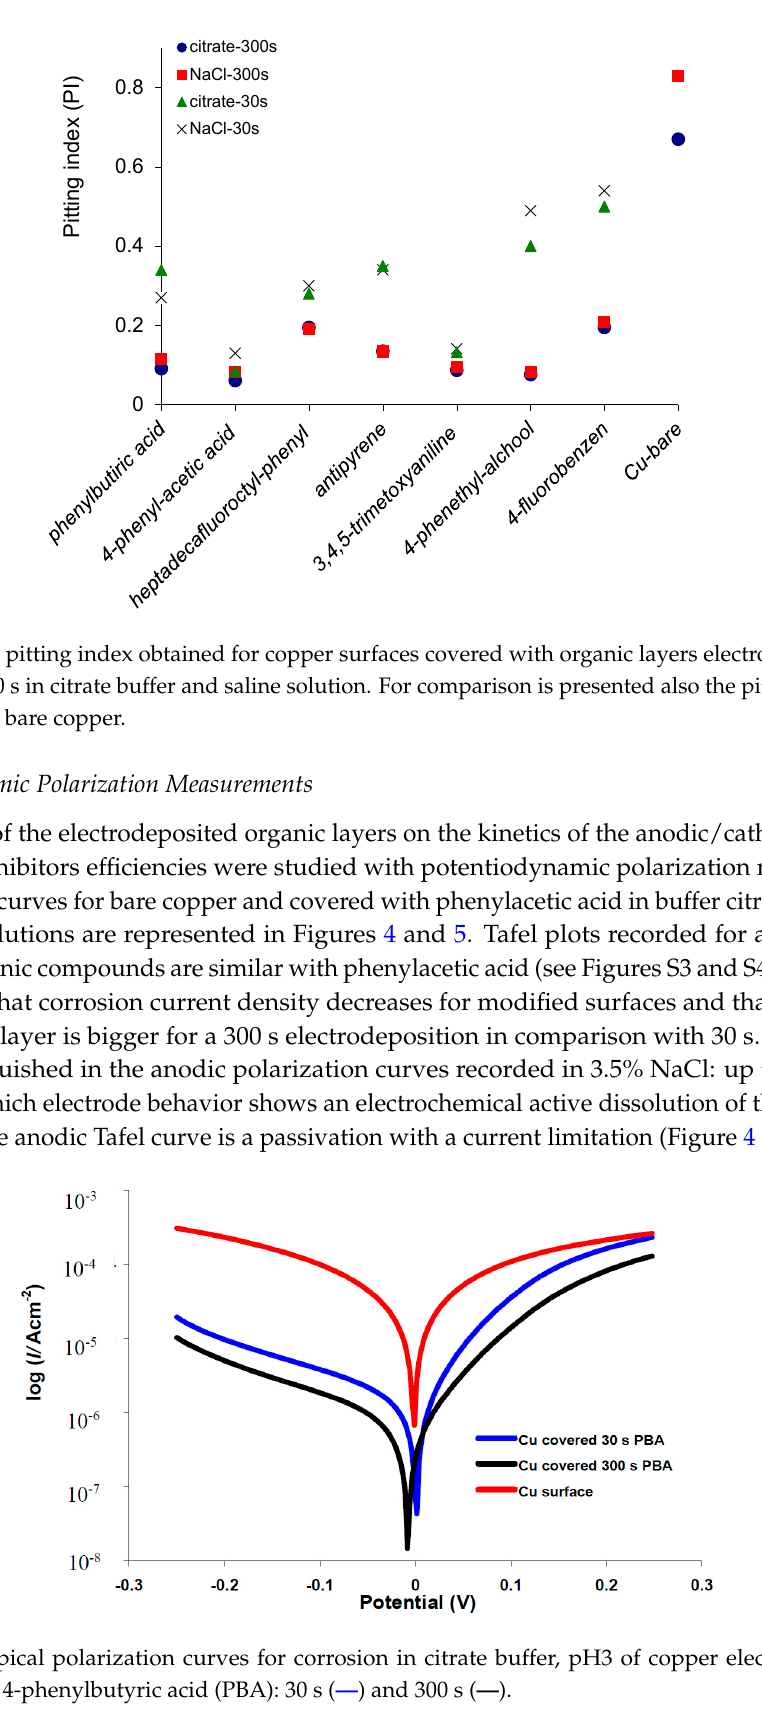
Figure 5. Typical polarization curves for corrosion in 3.5% NaCl of copper electrode ( ─ ), covered with 4-phenylbutyric acid (PBA): 30 s ( ─ ) and 300 s ( ─ ). The electrochemical parameters such as corrosion potential ( E corr ), corrosion current density ( i corr ), cathodic Tafel slope ( β c ), anodic Tafel slope ( β a ), polarization resistance ( R p ), and inhibition efficiency ( IE ) were calculated from Tafel plots and are presented in Table S2. The IE was calculated from polarization measurements according to the relation given below [31]: 100(%) corr inh corrcorr   i ii IE (3) were i corr and inh corr i are uninhibited and inhibited corrosion current densities. The E corr values measured in 3.5% NaCl are shifted with approximately 175 mV towards more negative potentials in comparisons with experiments carried out in buffer citrate pH = 3.00 for all investigated electrodes. The organic layer is considered to be a cathodic or anodic type inhibitor (corresponding to a potential shifts towards the negative or positive direction, respectively) if the inhibitor induces a modification of the E corr greater than 85 mV in comparison with the bare surface [32]. If the displacement in E corr is smaller than 85 mV, then the inhibitor mechanism can be